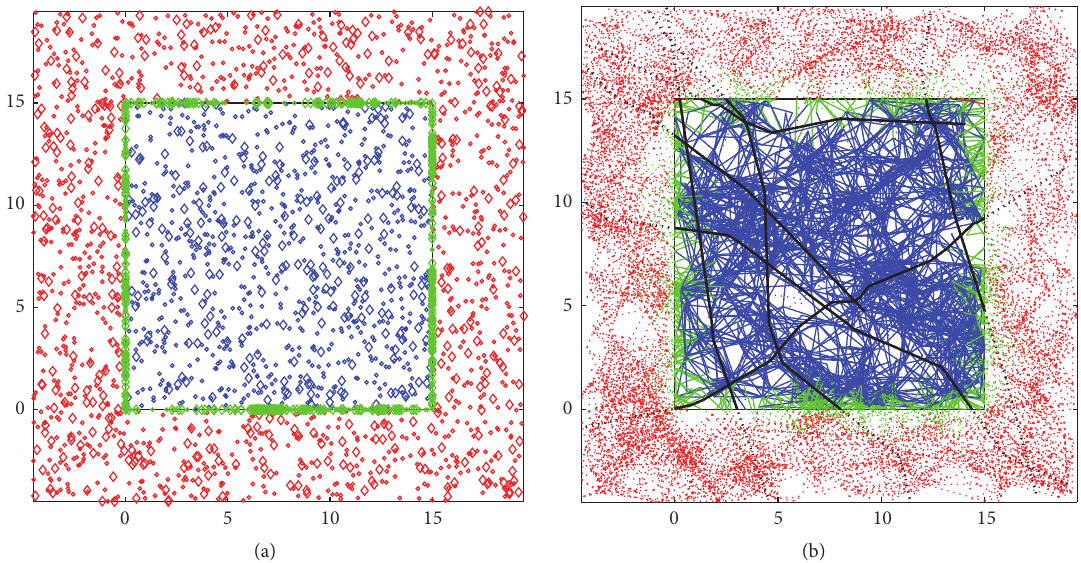
Figure 2: Trimming of the 15 × 15 MHD “box.” (a) New boundary nodes (green) are created where branches cross the perimeter of the box. (b) Trimming of elements to the “box.” Dashed lines represent trimmed dendrites (red) and CNTs (black). Space not occupied by the solid structure represents the voids (pores) of the